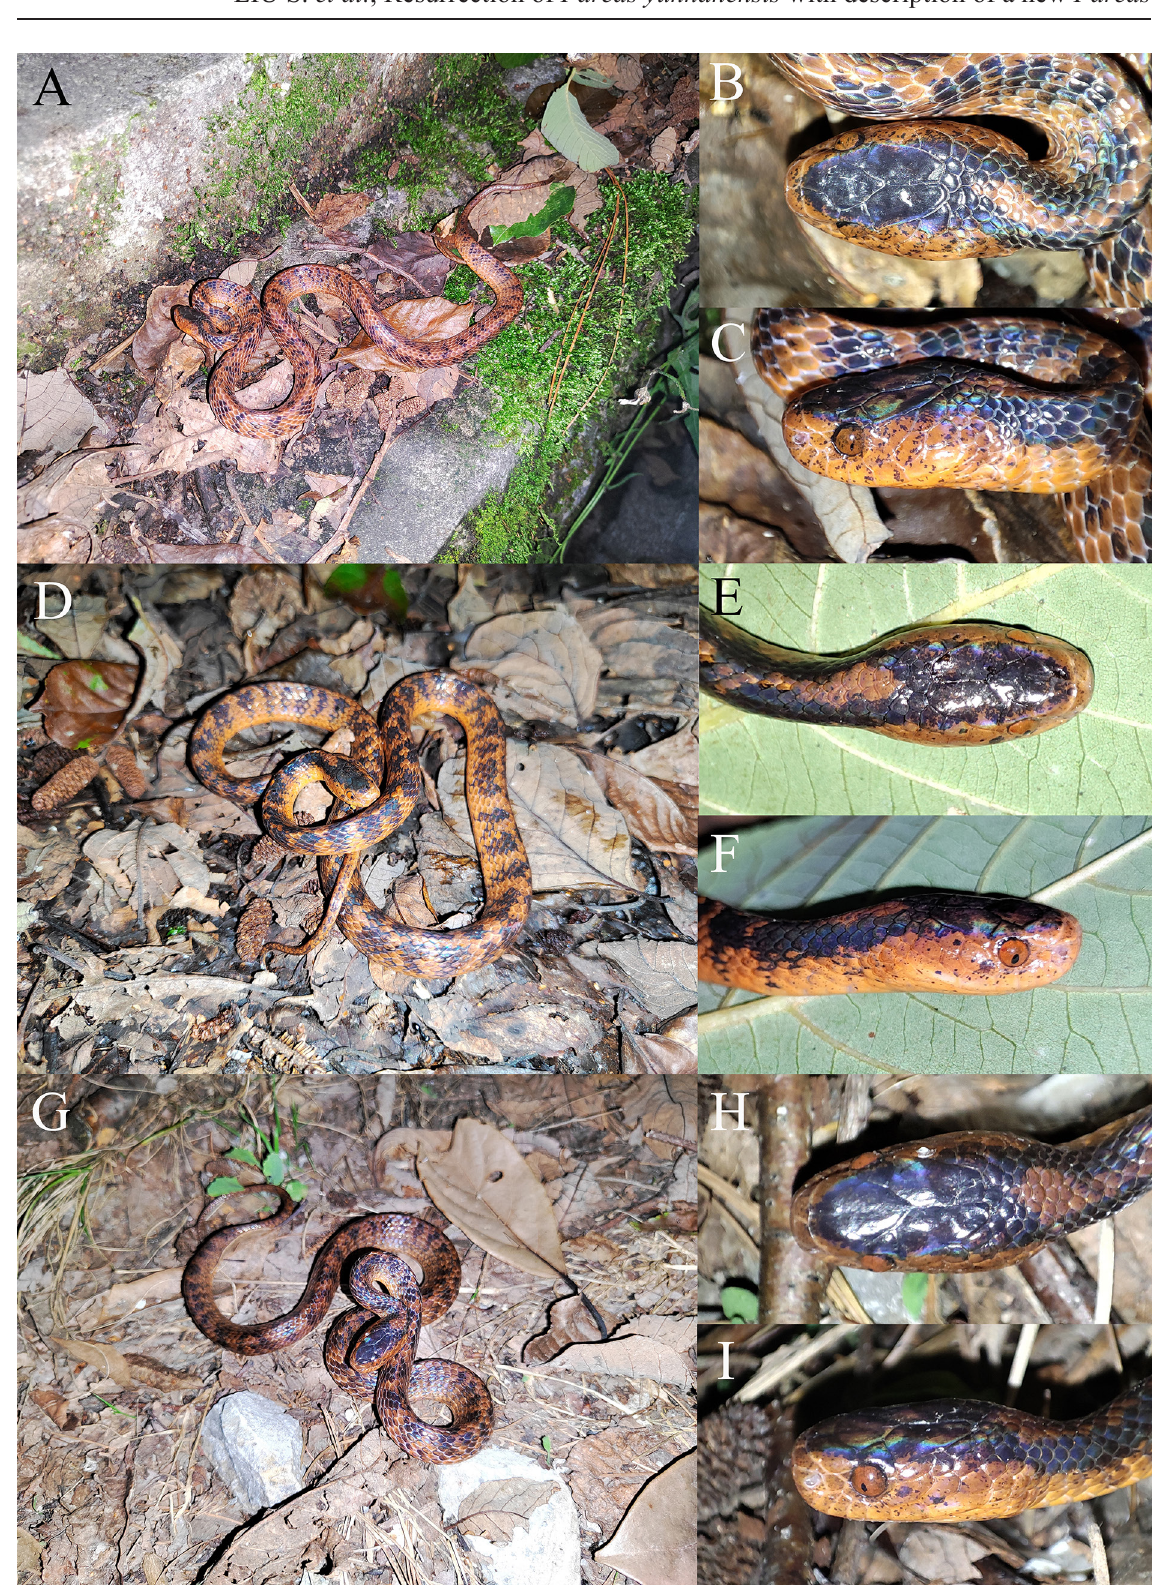
Fig. 4. Pareas yunnanensis (Vogt, 1922), specimens from its type locality in life. A–C . ♀, KIZ 2022033. D–F . ♀, KIZ 2022034. G–I . ♀, KIZ 2022035. Photos by S.